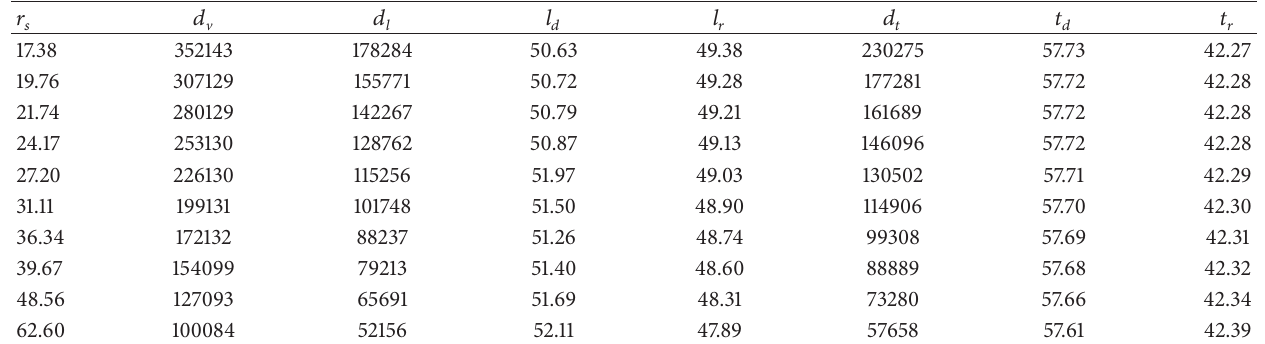
Table 2: Energy depletion, residual energy in different traversal patterns of MSNs.